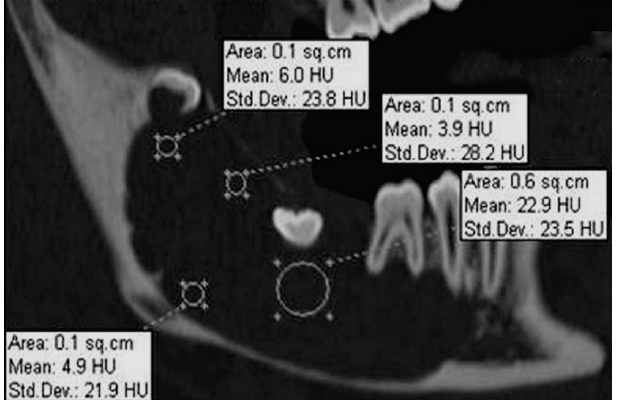
Figure 3. Sagital multi-slice computed tomography (MSCT) image: A large uniloculated lesion involving impacted mandibular right second molar. The lesion attenuation coe ffi cient varies from 3.9 to 22.9